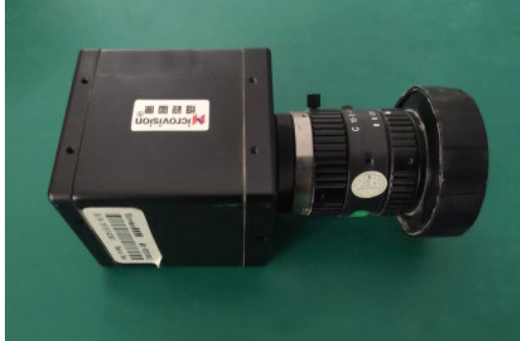
Figure 1. Camera for image acquisition.